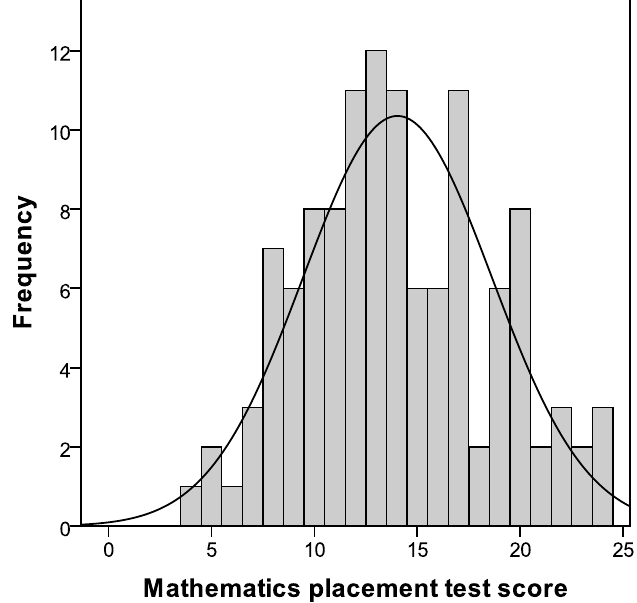
Fig. 1. The distribution of the mathematics placement test scores